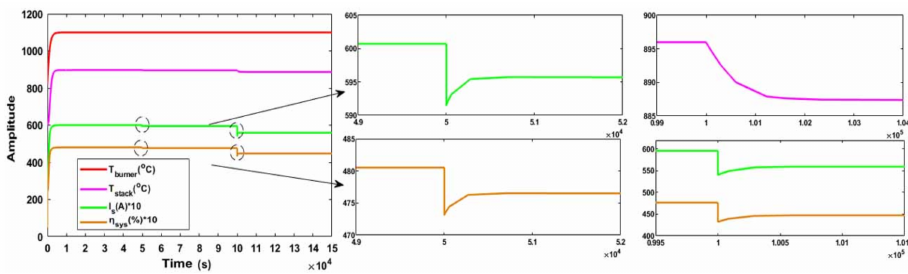
Figure 10. The performance parameter curve of system mode change caused by the reformer